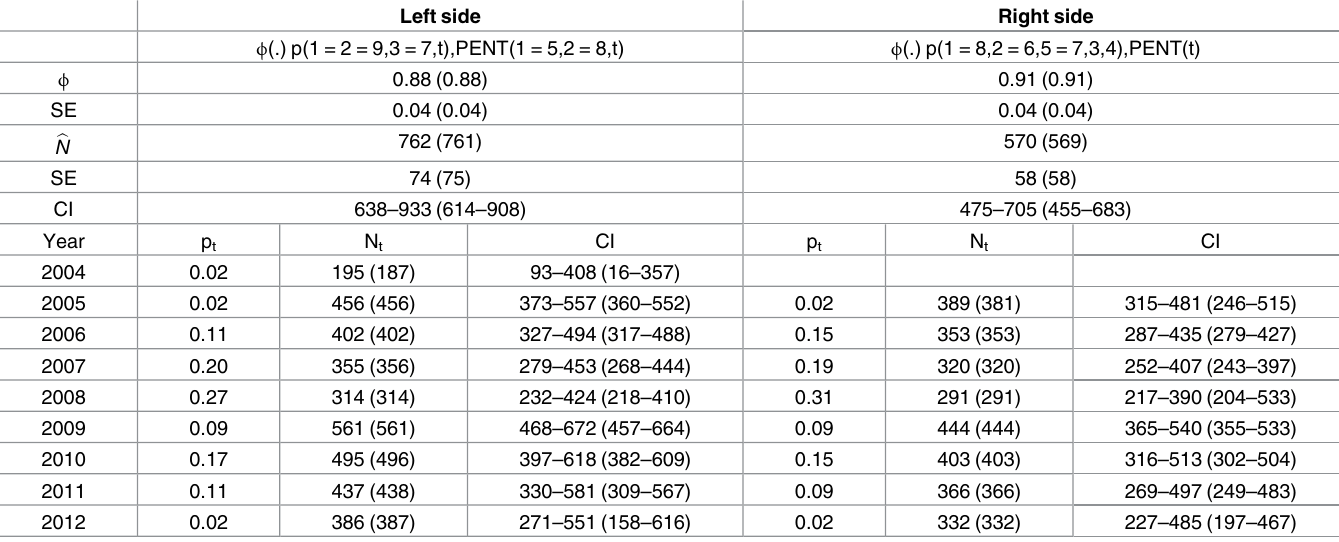
Shown in parentheses are the estimates derived from model averagingover all POPAN mark-recapture models explored in